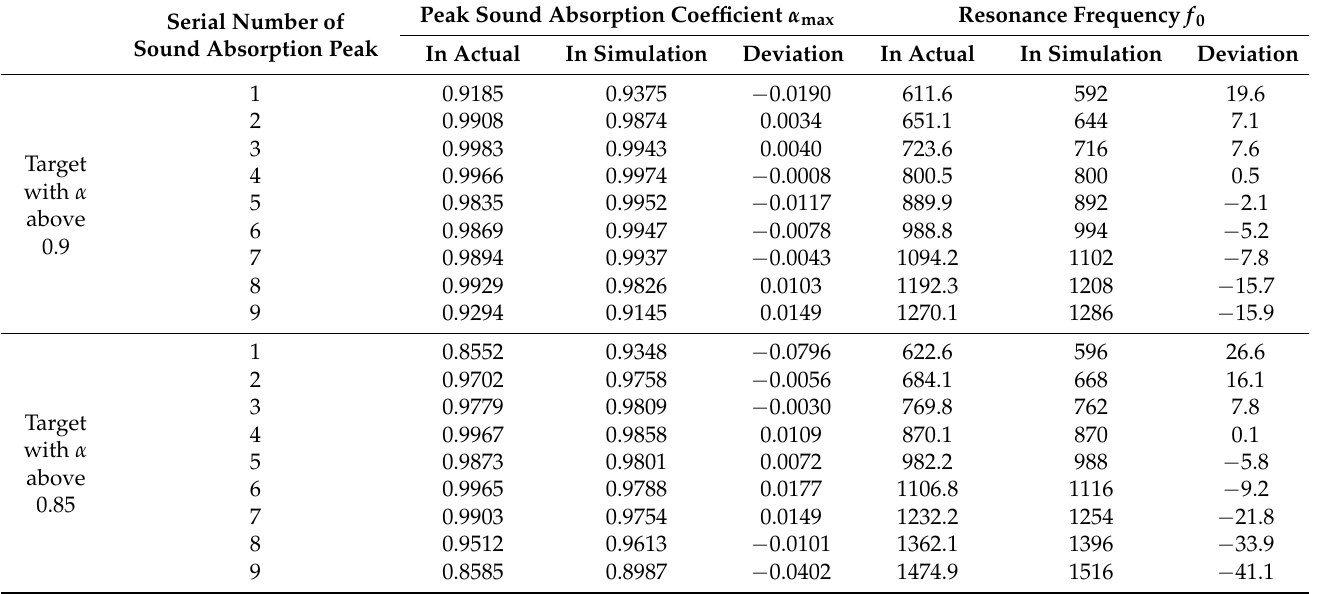
Table 6. The summary of the peak sound absorption coefficient α max and resonance frequency f 0 in actual and those in simulation for the optimized APH-AM